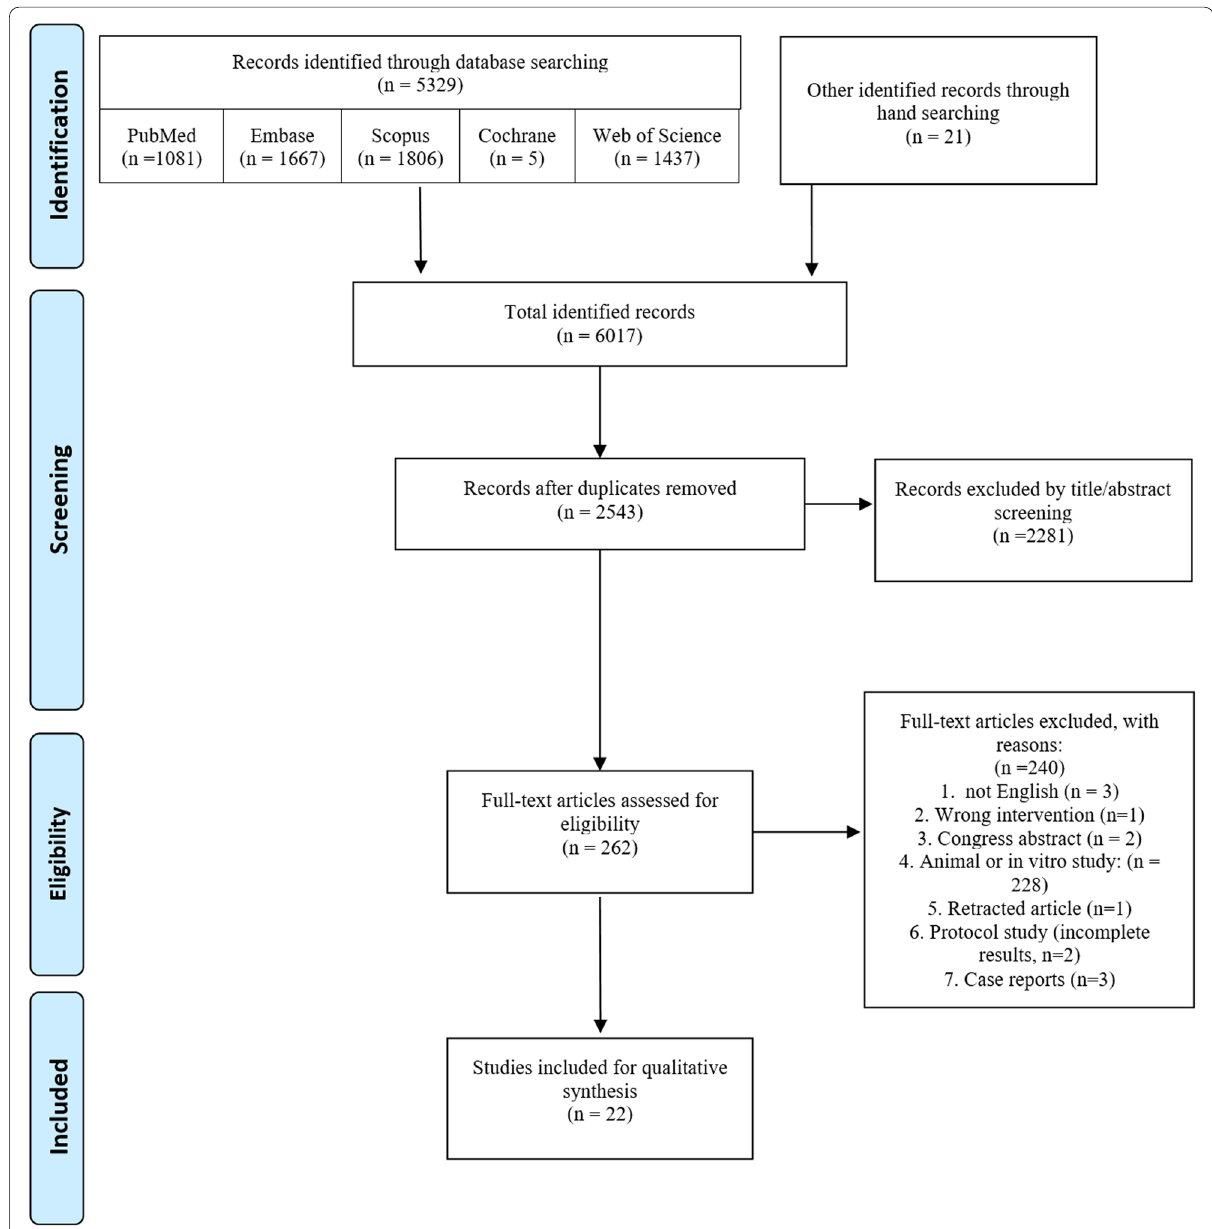
Fig. 1 Prisma flow diagram of the study’s selection